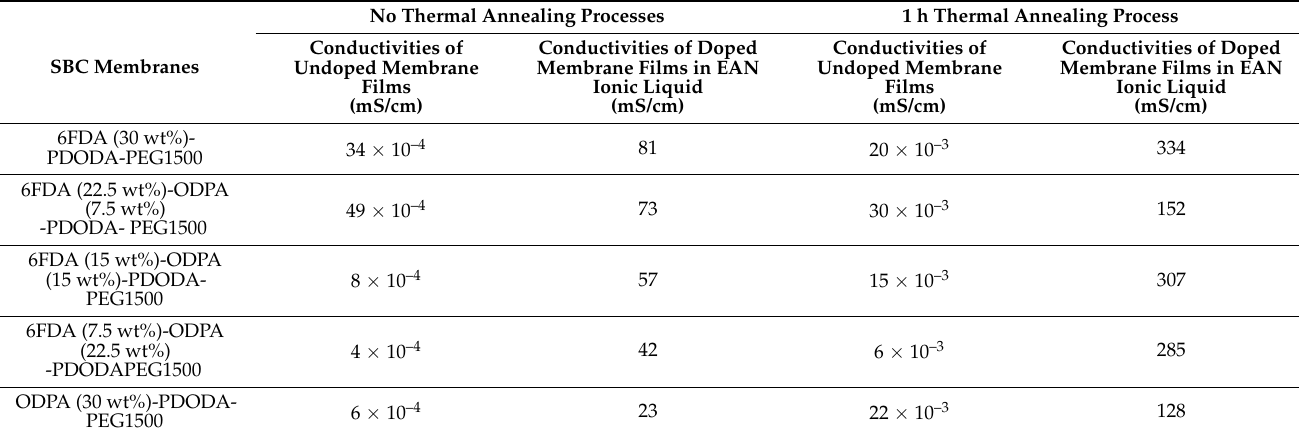
Table 6. Comparison of conductivity of membranes without and with thermal